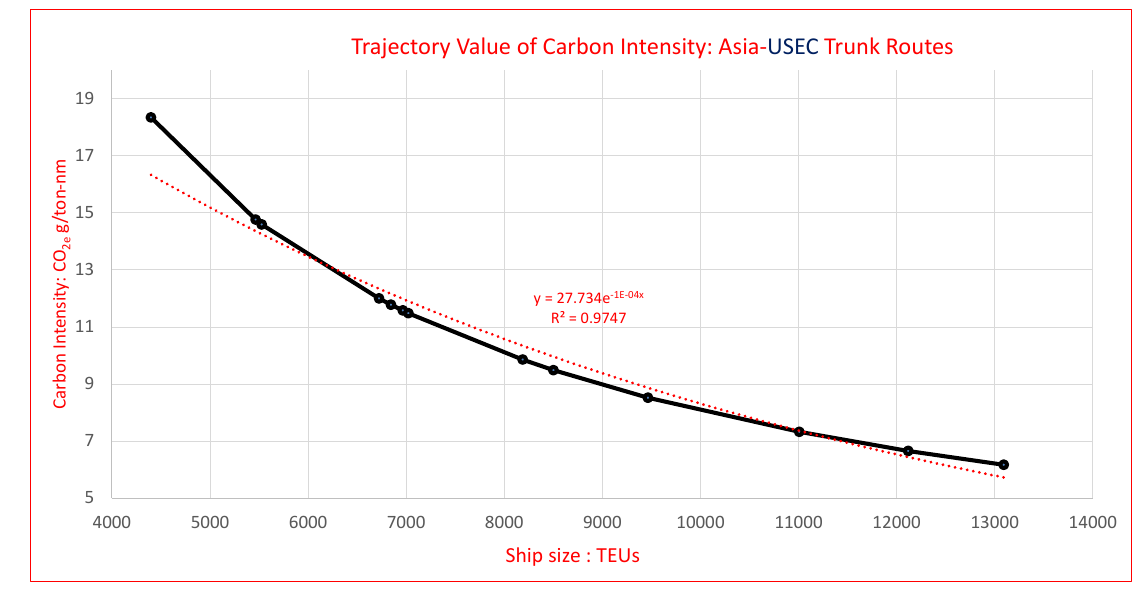
Figure 6. The Carbon Intensity against Ship Size of Route C.